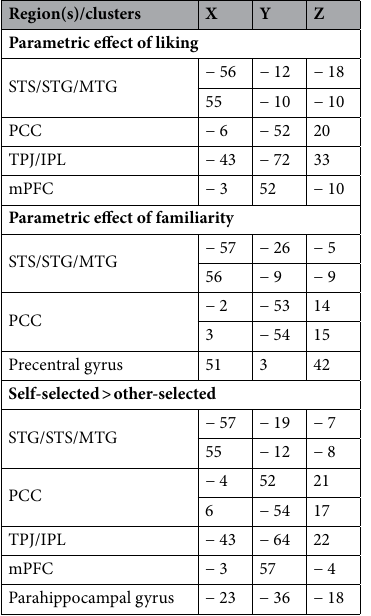
Table 2. Conjunction analysis of pre- and post-intervention. Voxel Threshold: p FDR corrected < 0.05; Cluster Threshold: p FDR <